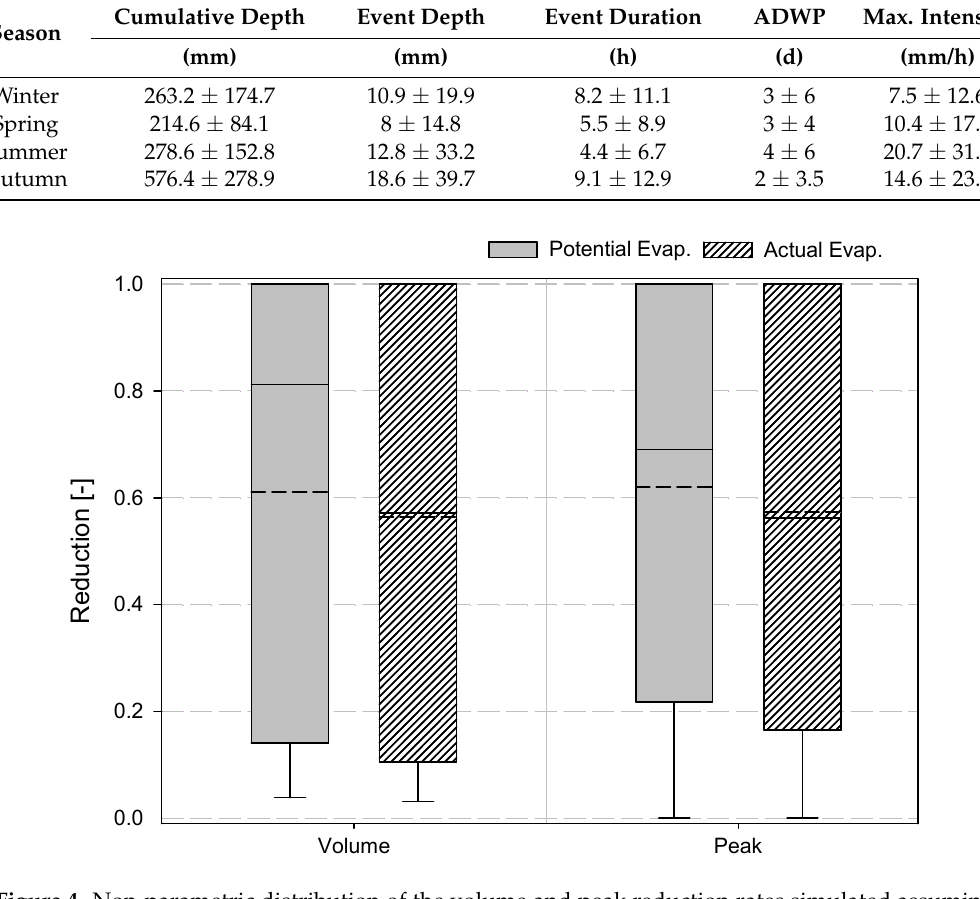
Table 6. Rainfall event characteristics (mean and standard deviation values) evaluated with respect to each season for the time series climate records (1990–2015) of Villa Cambiaso (Genoa, Italy). ADWP is the antecedent dry weather period and the maximum intensity is evaluated over 10 min.